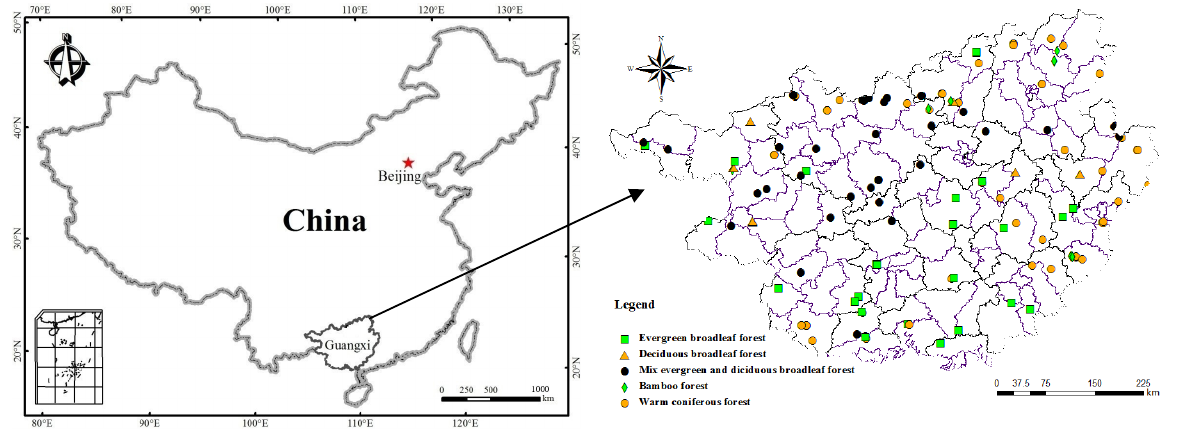
Figure 1. Schematic map showing distribution of the sampling sites across Guangxi Autonomous Region, China. Different symbols represent different types of forests.